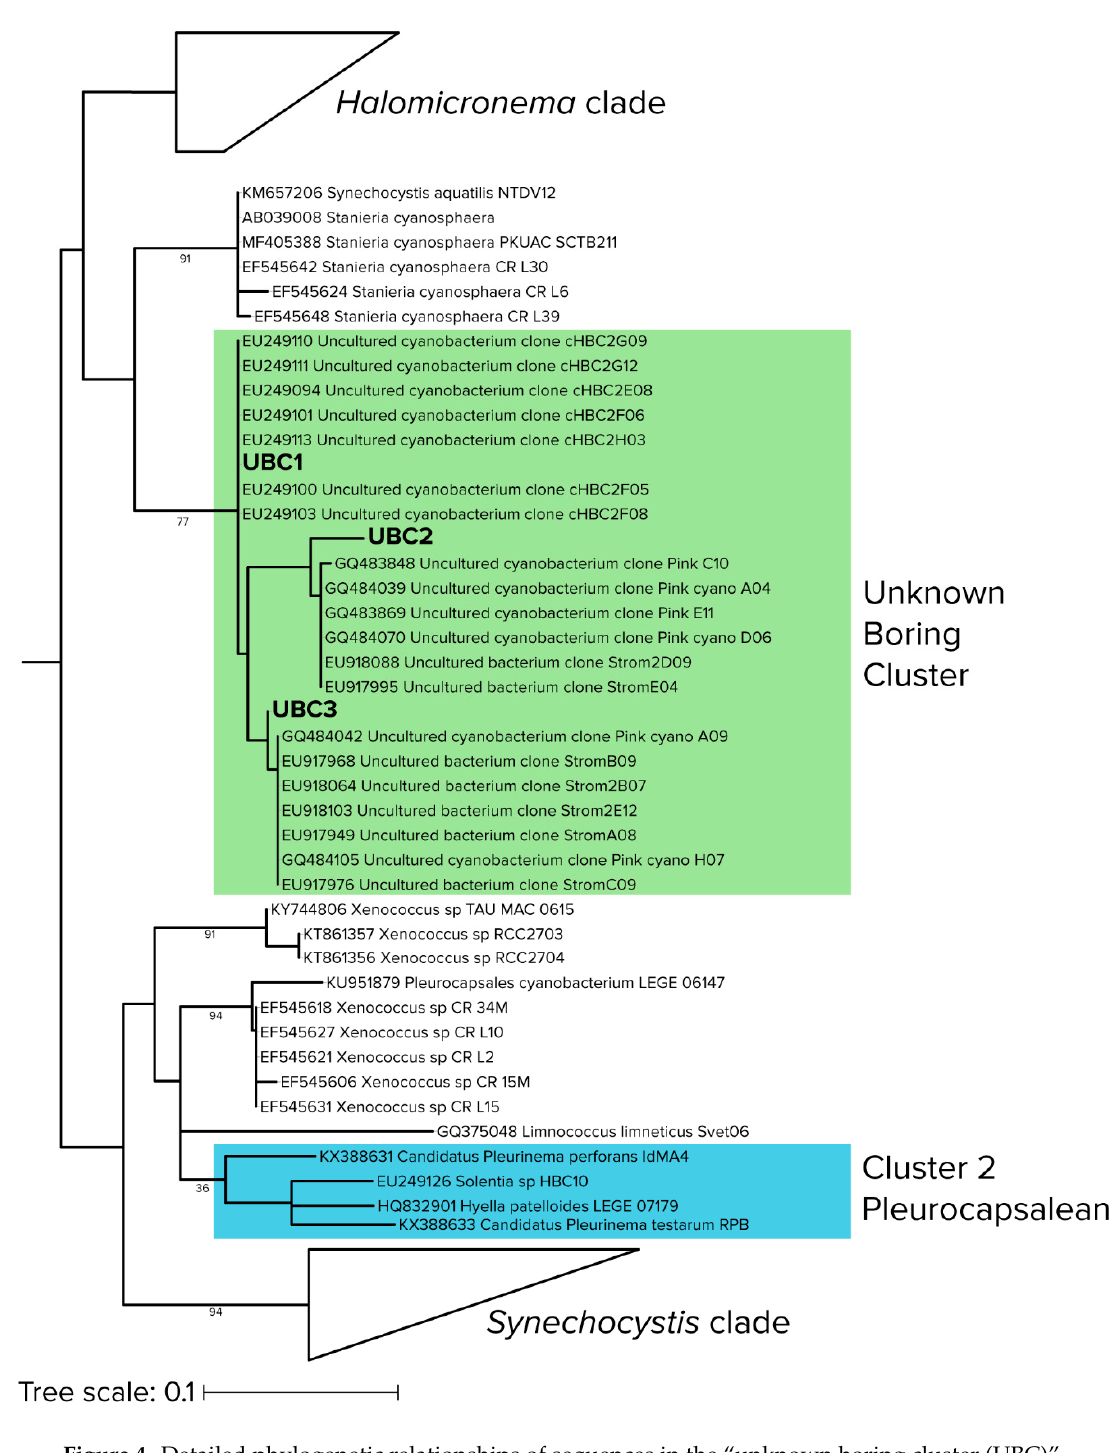
Figure 4. Detailed phylogenetic relationships of sequences in the “unknown boring cluster (UBC)”, with environmental (uncultured) cyanobacterial sequences from stromatolites (shaded in green) and the closest known euendolith cluster (shaded in blue). Branch lengths are substitutions per site and node labels indicate bootstrap values.